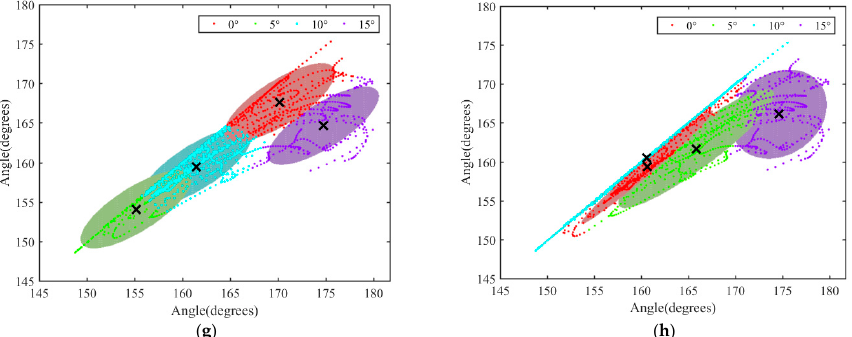
Figure 10. Clustering results of θ 2 data in the XZ and XY planes: ( a ) angle data of θ 2 in the XZ plane, when Sigmal was diagonal, and shared covariance was true; ( b ) angle data of θ 2 in the XZ plane, when Sigmal was diagonal, and shared covariance was false; ( c ) angle data of θ 2 in the XZ plane, when Sigmal was full, and shared covariance was true; ( d ) angle data of θ 2 in the XZ plane, when Sigmal was full, and shared covariance was false; ( e ) angle data of θ 2 in the XY plane, when Sigmal was diagonal, and shared covariance was true; ( f ) angle data of θ 2 in the XY plane, when Sigmal was diagonal, and shared covariance was false; ( g ) angle data of θ 2 in the XY plane, when Sigmal was full, and shared covariance was true; ( h ) angle data of θ 2 in the XY plane, when Sigmal was full, and shared covariance was false.